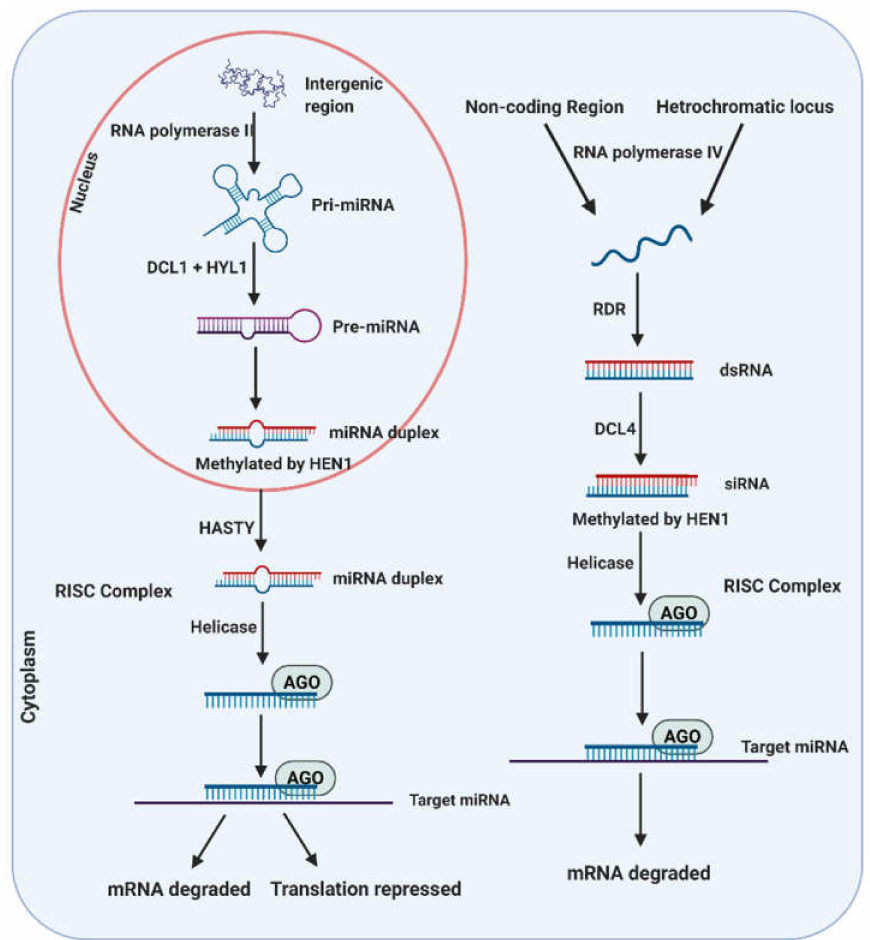
Figure 2. Schematic representation of biogenesis of sRNA (miRNA and siRNA) in plants. The miRNAs are processed from intergenic genome regions. Plant microRNAs are transcribed by RNA polymerase II and Dicer-like 1 (DCL1) in the presence of the protein Hyponastic Leaves 1 (HYL1) from the transcripts located in intergenic regions form miRNA duplexes. The miRNA duplexes are methylated by the Hua Enhancer 1 (HEN1) and HST protein (HASTY) which moves duplex miRNA from the nucleus to the cytoplasm. The guide miRNA strand binds AGO, making it accessible to the RNA-induced silencing complex (RISC) to carry out the translation repression or mRNA degradation. The biogenesis of siRNA depends on the type (Ra-siRNA heterochromatic locus and Ta-siRNA non-coding regions) of siRNA being synthesized. Single-stranded precursors are processed for the respective siRNAs by the activation of RNA pol IV or through miRNA-mediated cleavage. dsRNA is transcribed with the help of RNA-dependent RNA polymerases (RdRps) from the ssRNA precursor. DCL4 cuts dsRNAs to produce a duplex of siRNA that is methylated through HEN1. A helicase untwines the siRNA duplex and binds to RISC and then it binds to its target mRNA siRNA and degrades the